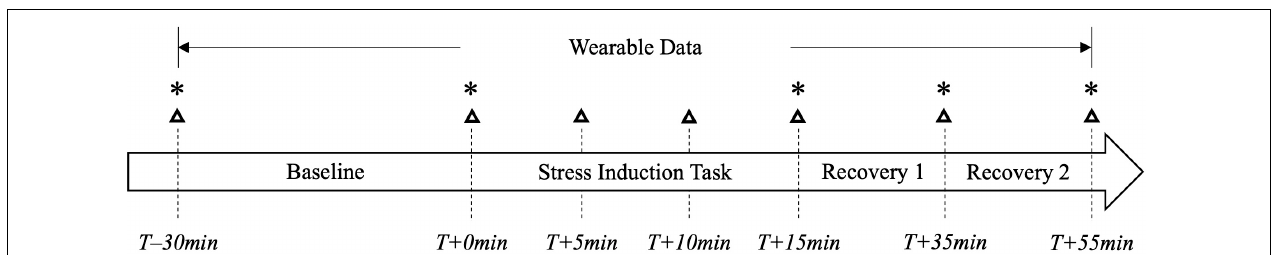
FIGURE 1 | Study design flow diagram.